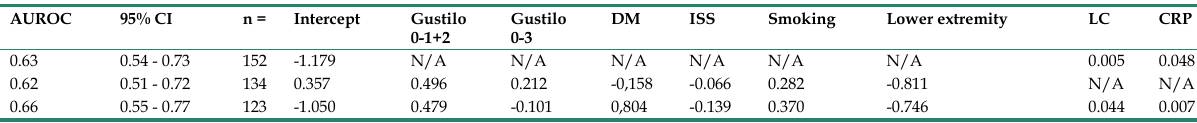
Table A. Models multivariable logistic regression analyses. AUROC 95%